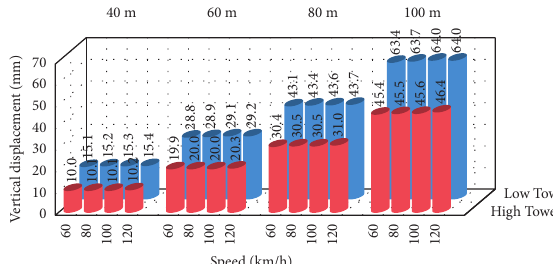
Figure 18: Comparison of vertical displacement.